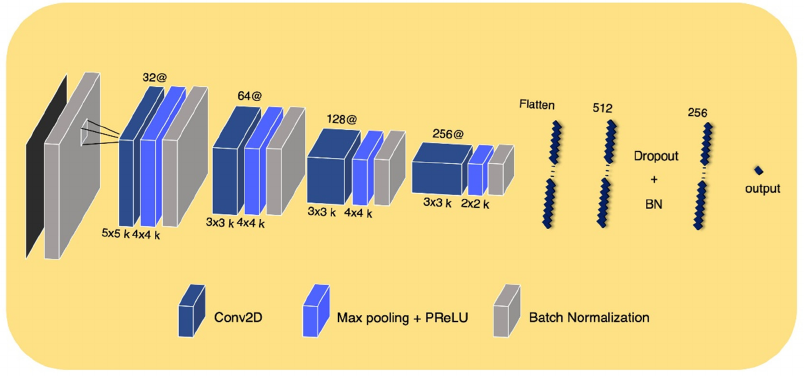
Figure 3. DLR convolutional neural network architecture .